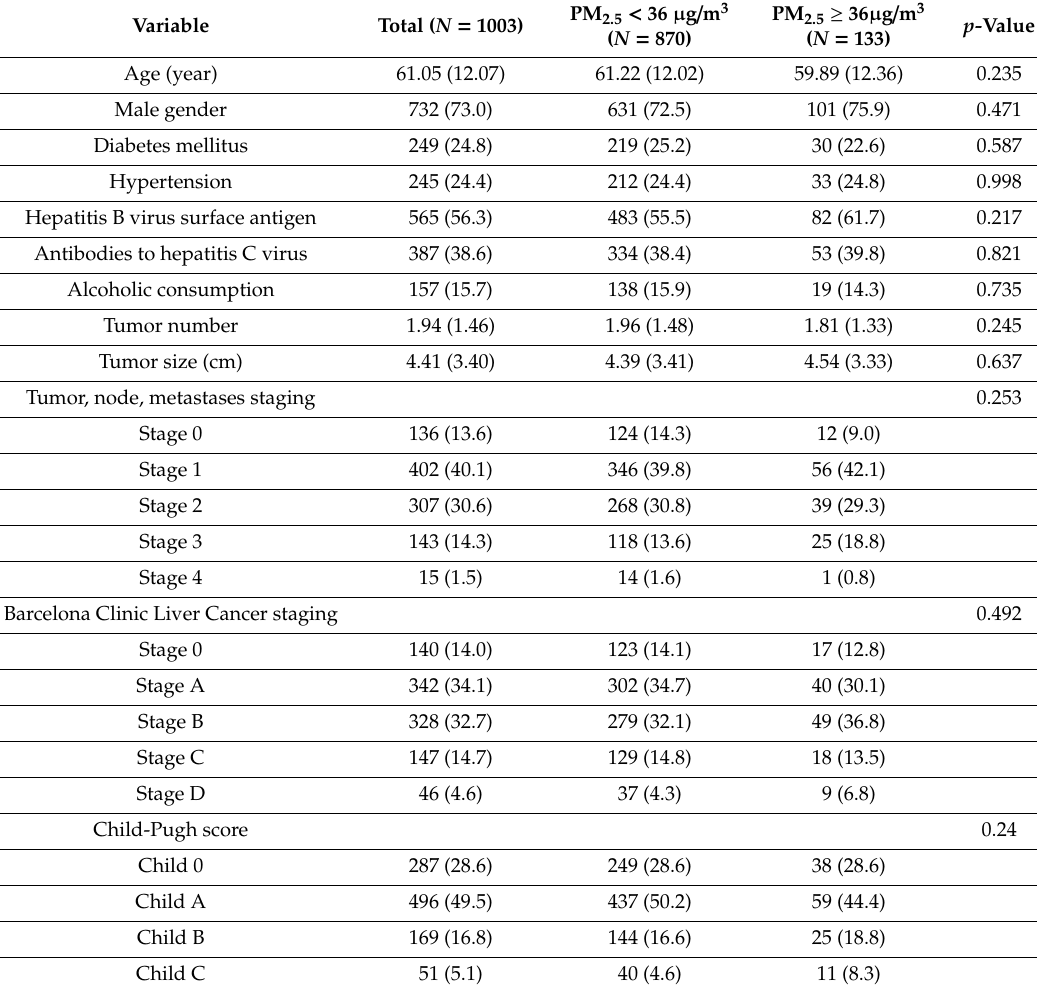
Table 2. Baseline characteristics of patients with HCC ( N =